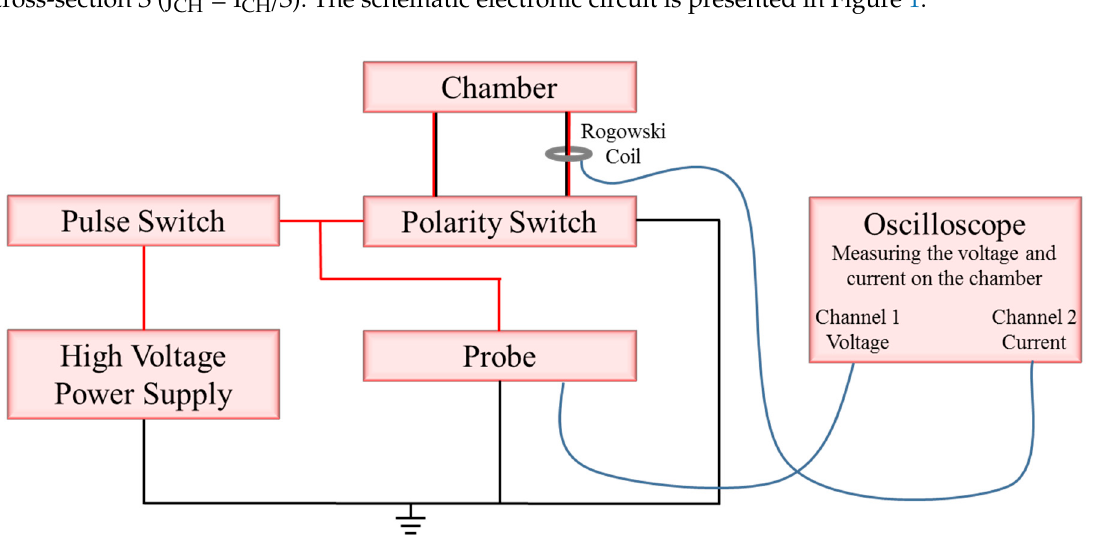
Figure 1. Schematic drawing of the high-voltage generator and the electronic circuit.